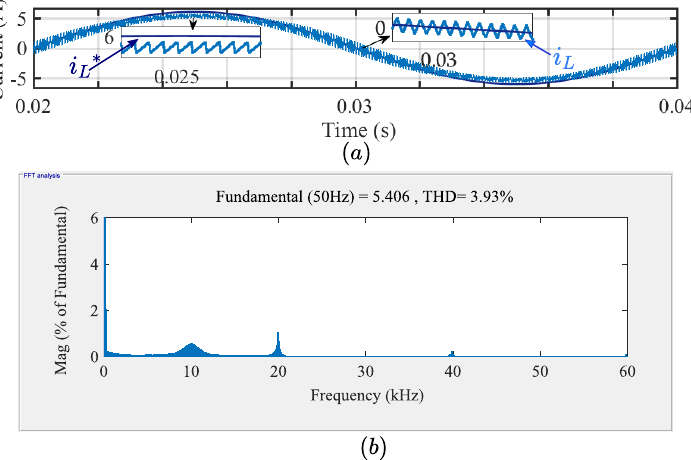
∆ i Lppmax ). ( b ) Fre- 2